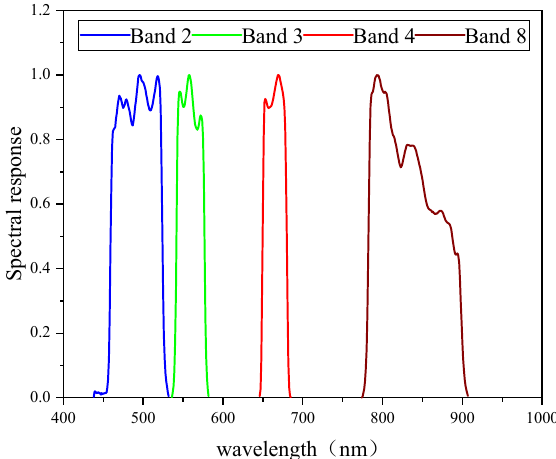
Figure 2. Spectral response function of Multispectral Instrument (MSI) onboard Sentinel-2B satellite. Twelve scenes of Sentinel-2B/MSI images under clear-sky conditions over the Baotou site are